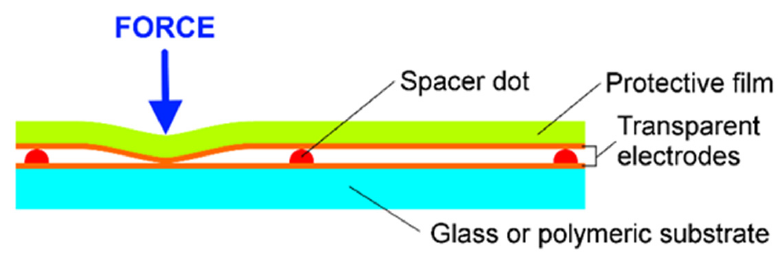
Figure 8. Design of a resistive touch screen.